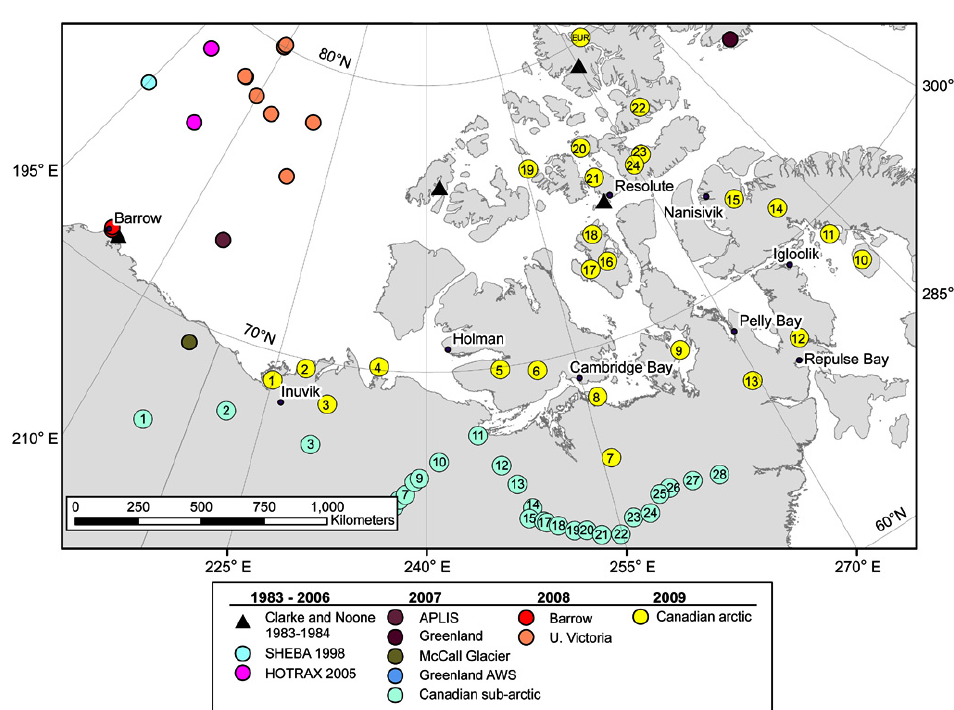
Fig. 3. Map showing sampling locations in Canada and Alaska (2007 and 2009) and vicinity. The numbering of Canadian subarctic and Canadian Arctic sites corresponds to the numbering in Table